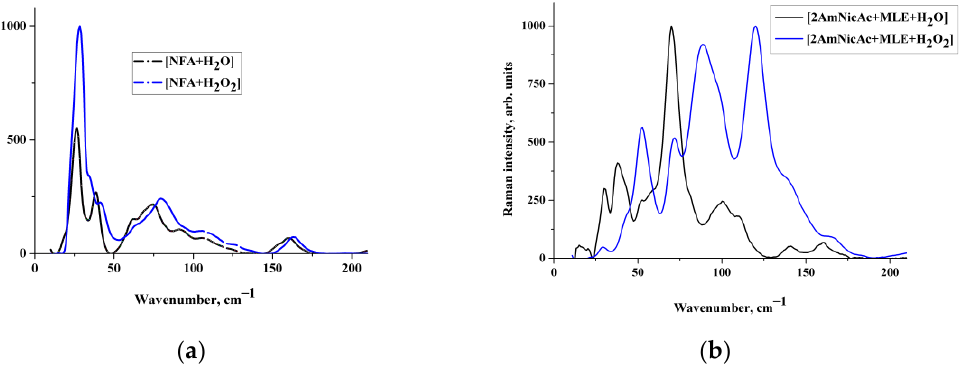
Figure 3. The experimental low-frequency Raman spectra of the [NFA+H 2 O] and [NFA+H 2 O 2 ] com- plexes ( a ); the [2AmNic+Mle+H 2 O] and [2AmNic+Mle+H 2 O 2 ] complexes ( b ) .